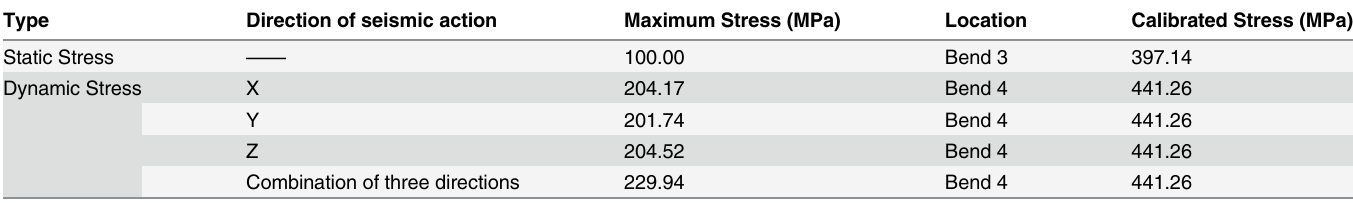
Table 8. Pipeline stress calibration under static and dynamic